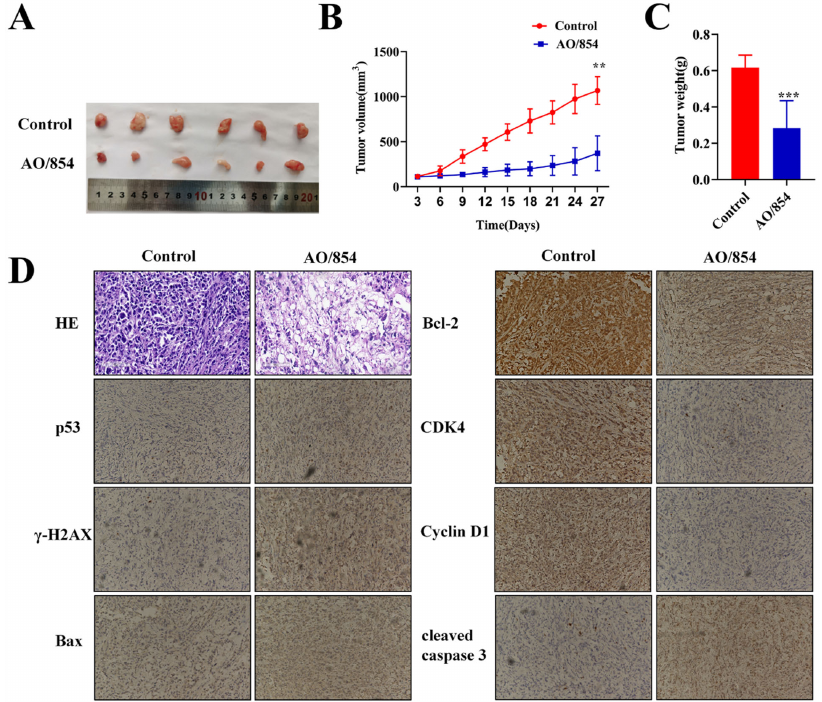
Figure 10. AO/854-suppressed tumor growth in the PC3 xenograft model (n = 6). ( A ) Representative images of PC3 xenograft tumors after AO/854 (2 mg/kg, once every two days) or 0.9% saline treat ‐